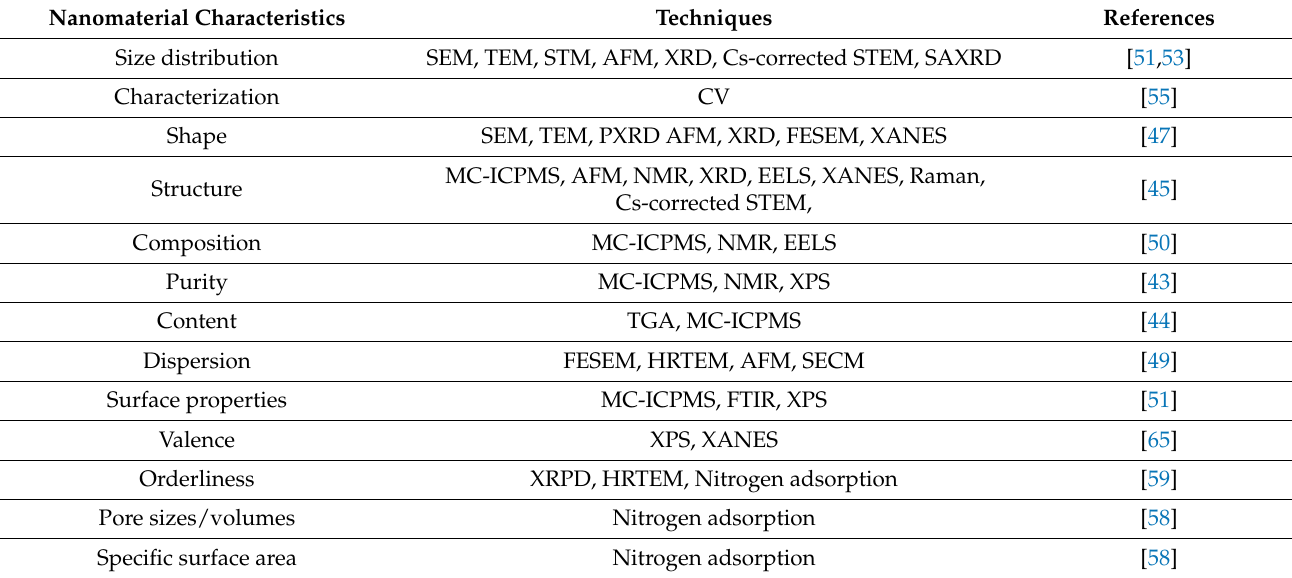
Table 1. Physicochemical characteristics of graphene-based